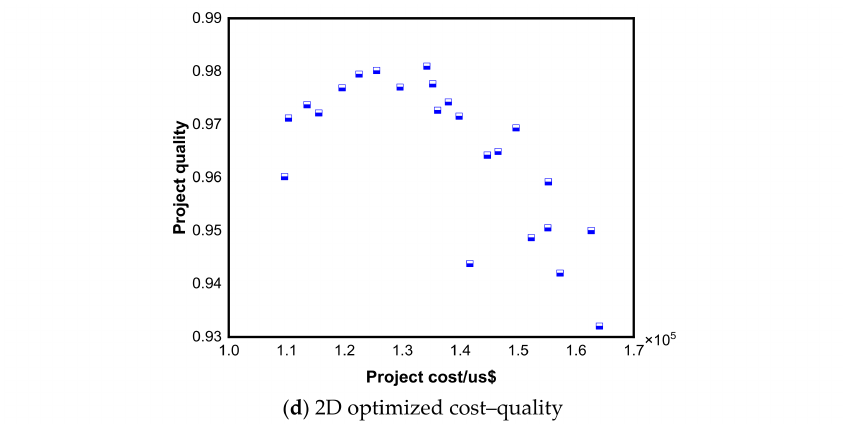
Figure 6. Model 1: 3D optimal results ( a ), and 2D period–cost, period–quality, and cost–quality relationships ( b , c , d , respectively).